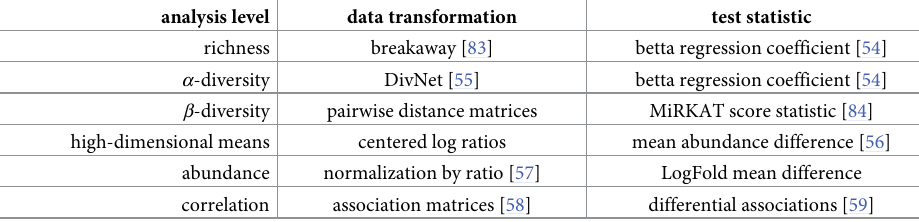
Table 3. Data transformation and choice of test